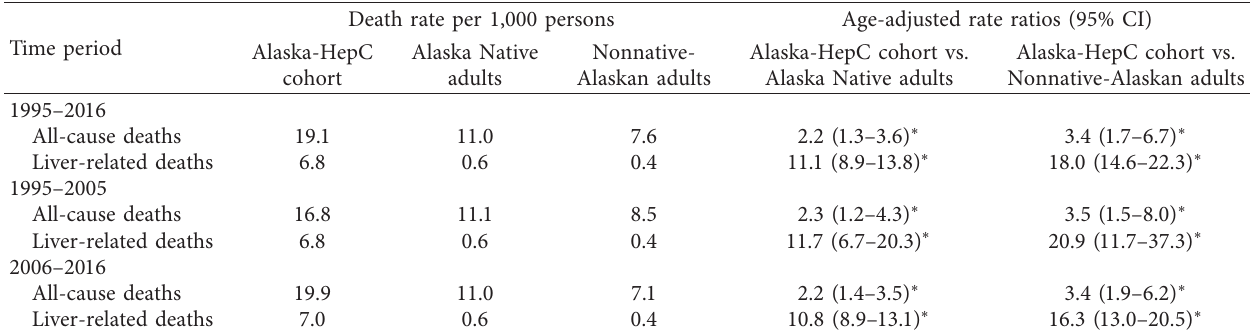
Table 2: Annual age-adjusted death rates for the Alaska-hepatitis C cohort and Alaska Native and Nonnative adults in Alaska, 1995–2016. † Death rate per 1,000 Time period